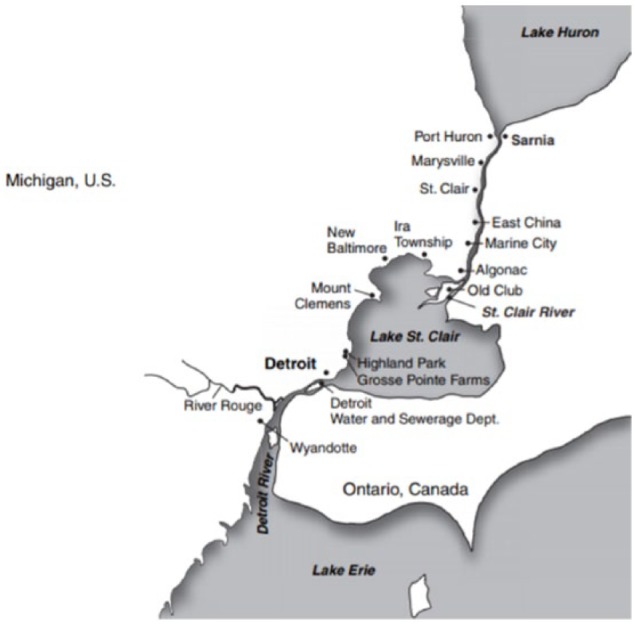
Map of the study area.3